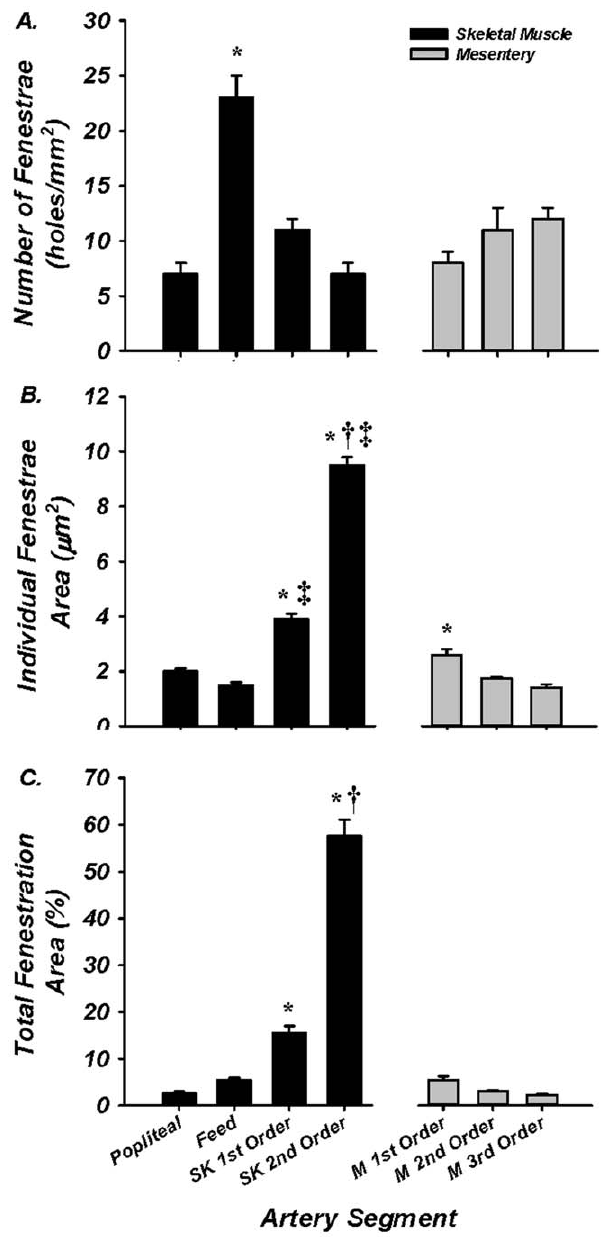
Figure 3. IEL fenestrae number, size, and total area. While all vessel segments had fenestrae, skeletal muscle feed arteries had a significantly greater number than all other vessel segments within skeletal muscle (black) and mesentery (gray); (A). Individual hole area for skeletal muscle first and second order arterioles and first order mesenteric arterioles was significantly different from all other vessel segments (B). Compilation of total fenestrae number and individual fenestrae size produced total MEC area as a percent. First and second order skeletal muscle arterioles had significantly greater area than all other artery segments. *= P , 0.05 vs all other artery segments; { = P , 0.05 vs 1 st order skeletal muscle arteriole; { = P , 0.05 vs 1 st order mesenteric